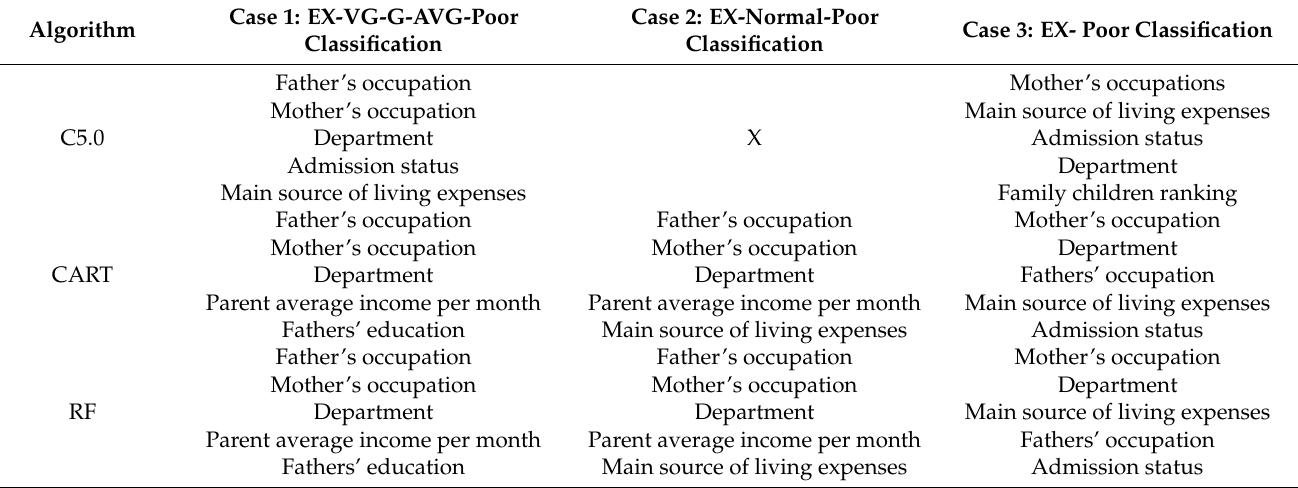
Table 9. Comparisons of DT and RF in the top 5 important